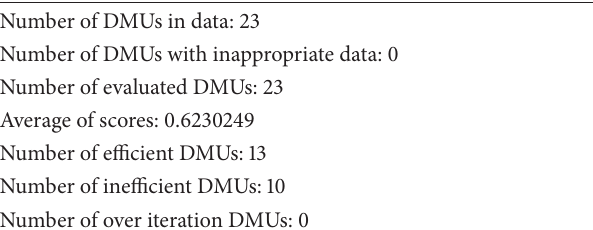
Table 7: Summary of super SBM results for